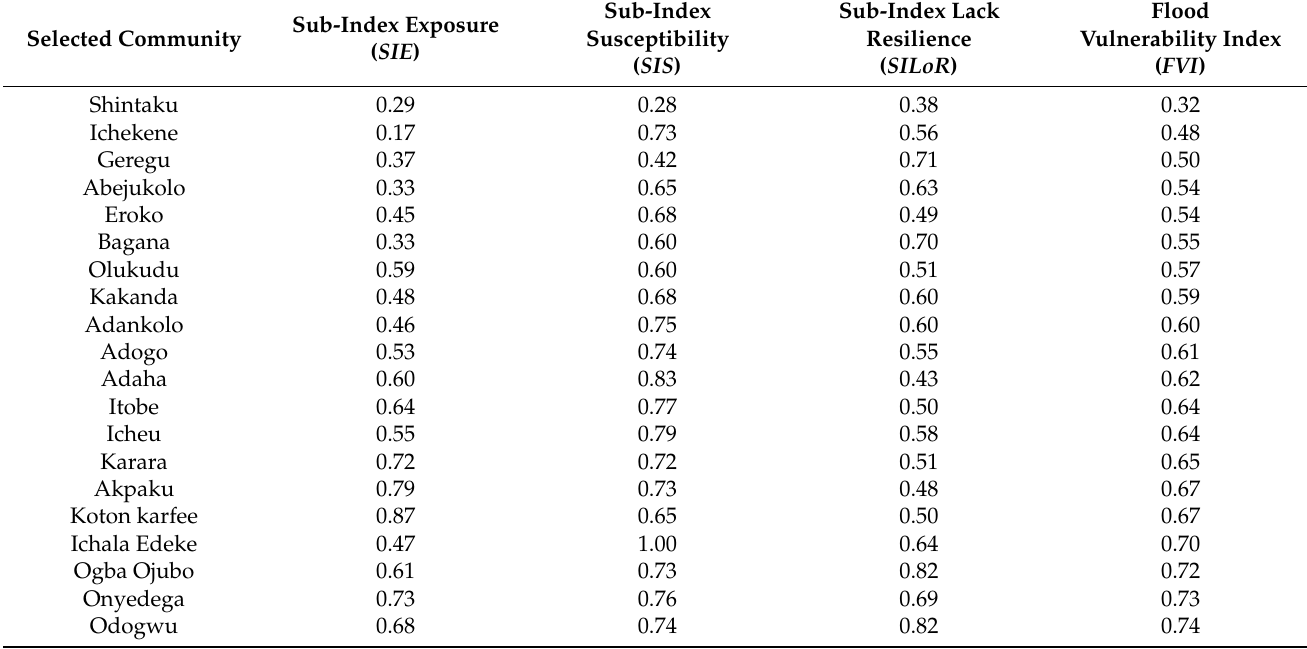
Table 4. Kogi State flood-prone communities’ Flood Vulnerability